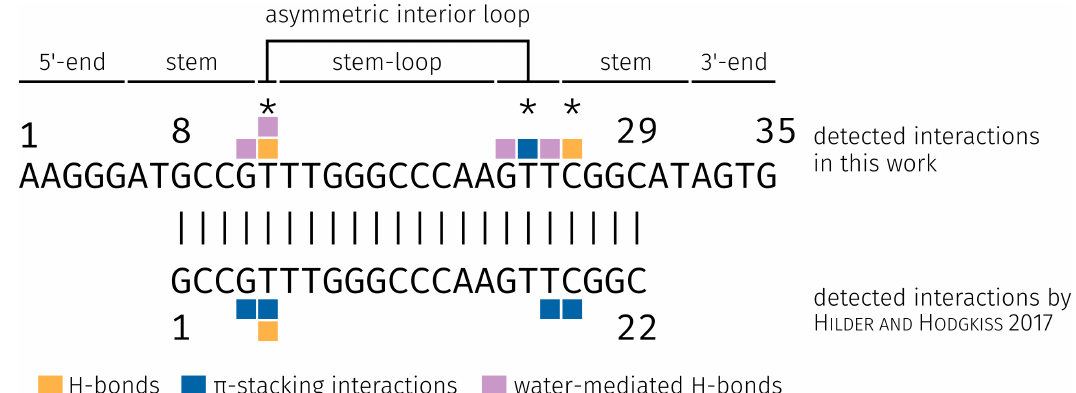
Figure 10. Comparison and local sequence alignment of the E2-specific aptamers. Both aptamers were identified by Alsager et al. [16]. The detected interaction bases of the aptamers and their different interaction types with E2 from the study of Hilder and Hodgkiss [35] and from this work are highlighted. The various secondary structures of the E2-specific aptamer are shown above the plot and the main binding bases of E2 are highlighted with the asterisk symbol ( ∗ ). H-bonds, hydrogen